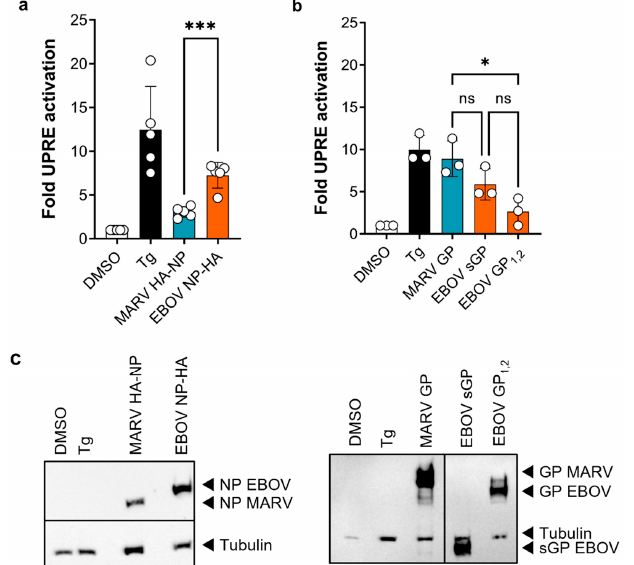
Figure 5. EBOV NP and EBOV sGP activate the UPRE reporter in HuH7 cells. ( a ) Cells were transfected with the UPRE reporter plasmid, with pGL4.73, and with plasmids encoding EBOV NP, MARV NP or with empty vector (DMSO and Tg). 48 h after transfection (p.t.), luciferase activities